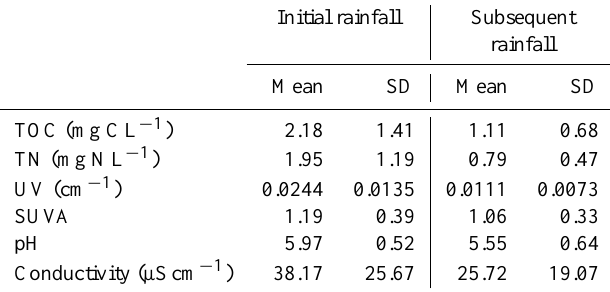
Table 7. Mean values of TOC, TN, UV, SUVA, and pH and con- ductivity in initial ( n = 40) and subsequent ( n = 73) rainfall during